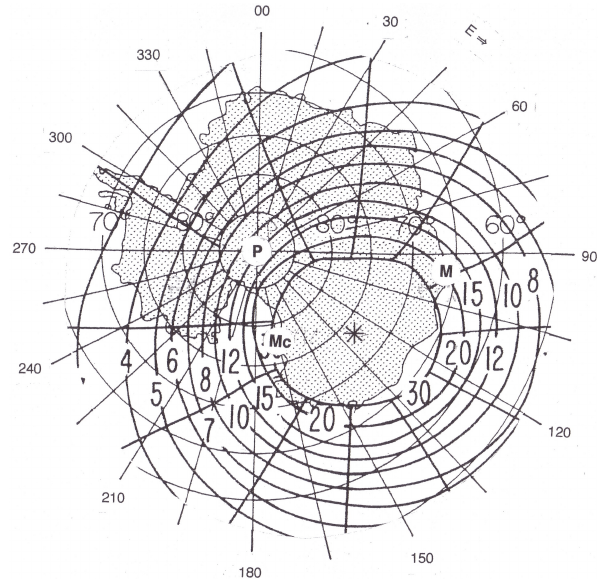
Fig. 6. Map of Antarctic continent with stations South Pole (SPA), Mirnyy (MIR) and McMurdo (MCM), and constant L